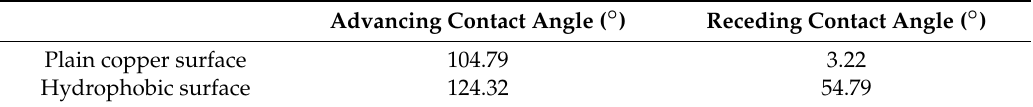
Advancing and receding contact angles of the plain copper surface and the hydrophobic